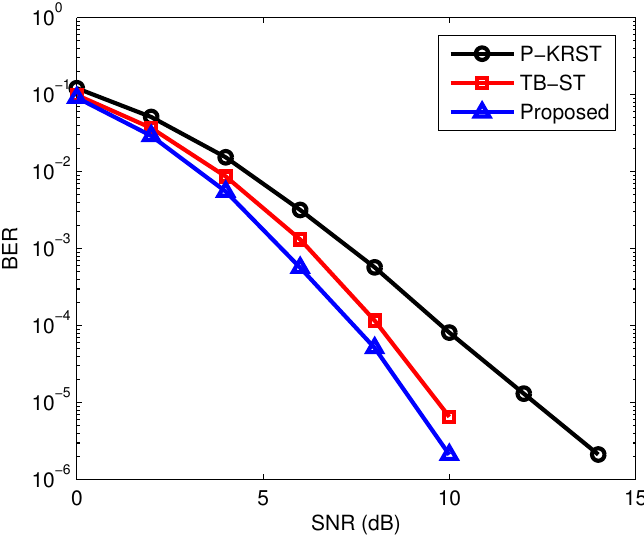
Figure 3. Bit error rate (BER) performance of different receivers versus signal-to-noise ratio